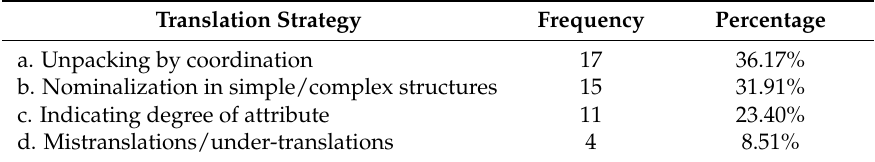
Table 2. Frequency and percentage of explicit negation strategies in rendering too